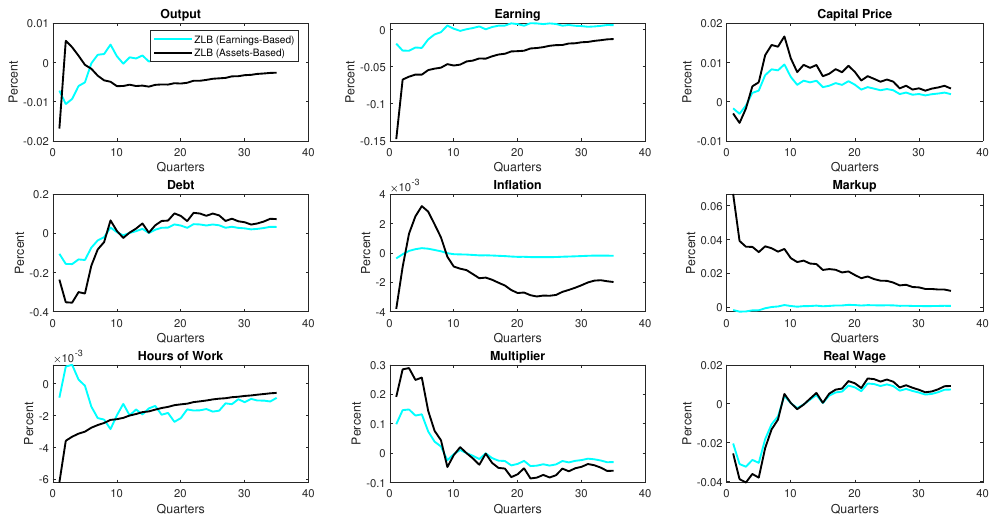
Figure A10. Impulse Responses at the ZLB When Earning-Based Constraints Are Binding. Notes : The figure displays model IRFs of different model variables to technology uncertainty shocks when the nominal interest rate is subjected to the Zero Lower Bound infinitely, under two alternative calibrations in which only the earnings-based constraint (cyan colored lines) or only the assets-based constraint ( black colored lines) is present. The structural parameters to generate these IRFs are shown in Table 2. Based on a VAR analysis (not shown), we calculate ρ σ = 0.0122 and σ